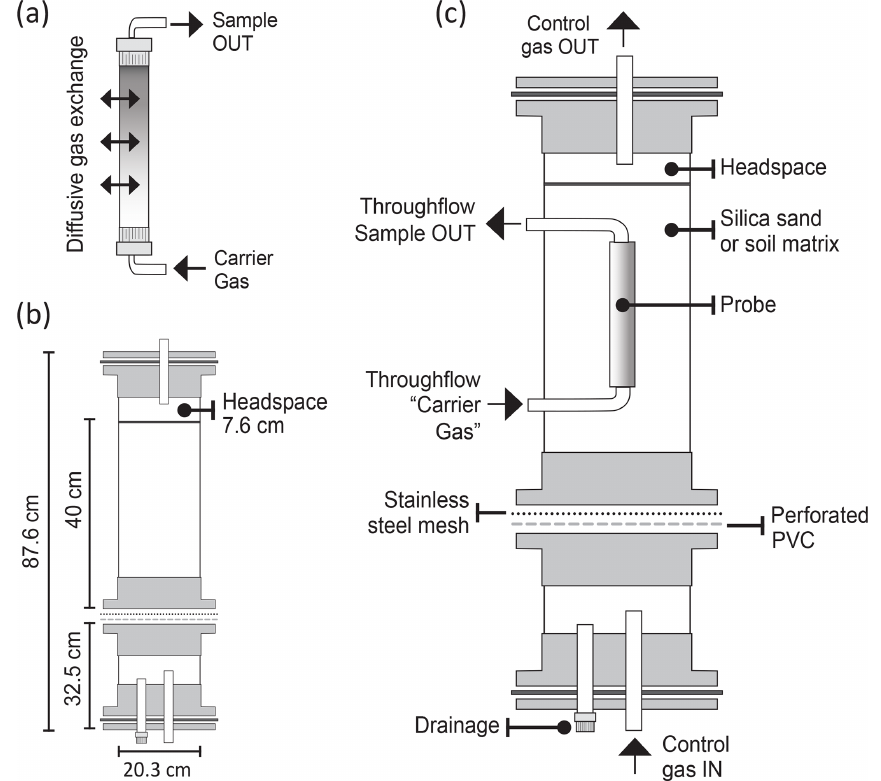
Figure 1. Gas probe and soil column assemblies: (a) microporous probe of sPTFE, (b) dimensions of the two column sections of the custom soil column assembly built to evaluate probe performance, and (c) probe and column components for probe